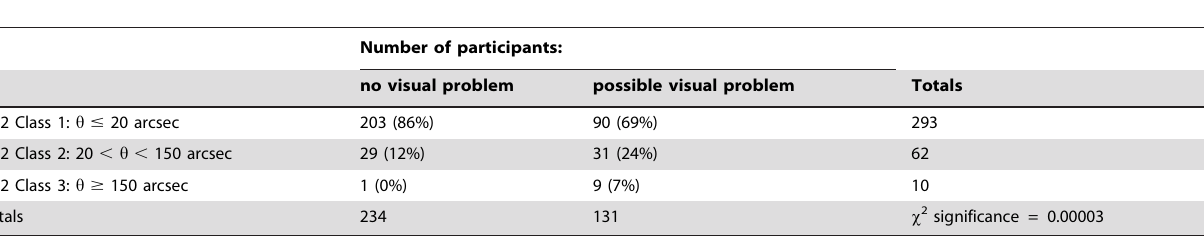
Table 5. Contingency table showing relationship between visual problems and stereo classification on the FD2 test.